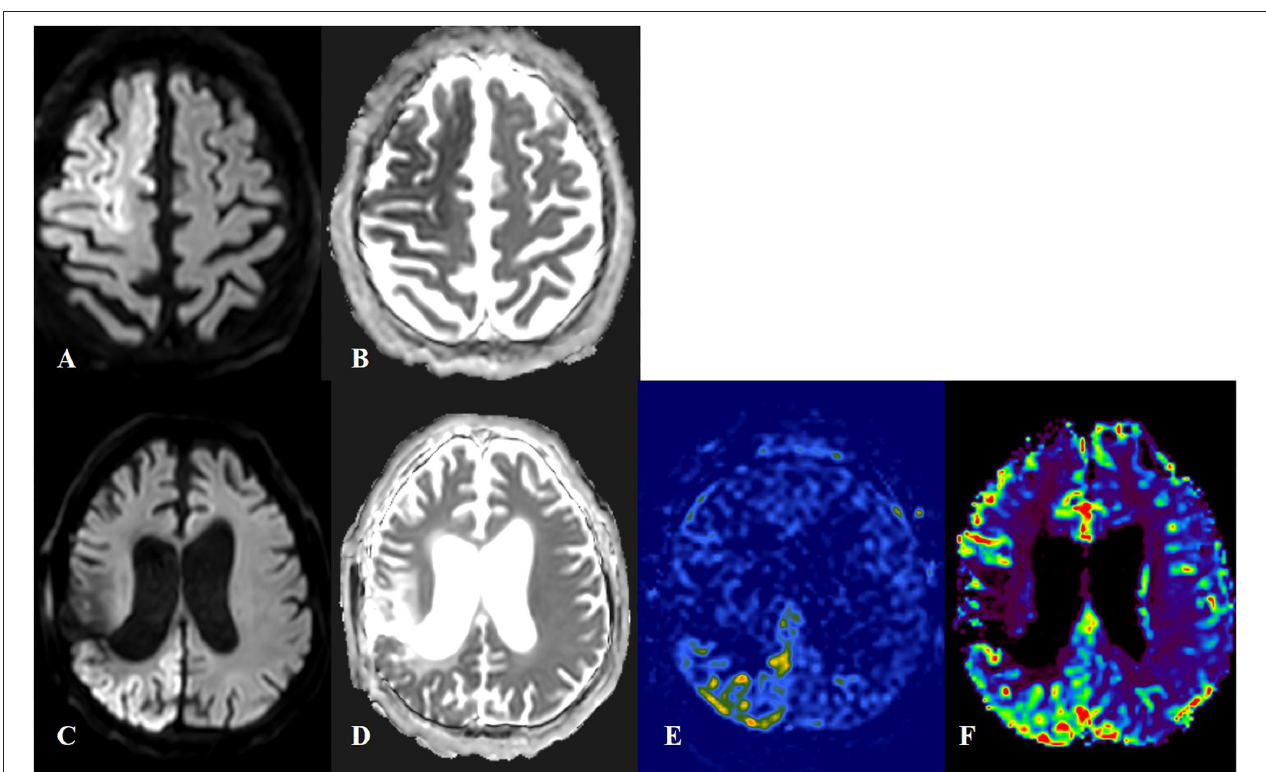
FIGURE 4 | Cortical laminar necrosis in acute ischemic stroke (AIS) and status epilepticus (SE). First row: Patient with AIS in territories of right anterior and middle cerebral arteries, with an increased signal in diffusion-weighted imaging (DWI) (A) and decreased signal in apparent diffusion coefficient (ADC) (B) . Quantification of DWI and ADC signals was done for the lesion side as compared to the contralateral healthy mirror side. The ratio for DWI lesion/healthy side was 1.70 and the ratio for ADC lesion/healthy side was 0.58. Second row: Patient with SE. The DWI-restricted lesion in the right parieto-occipital region (C,D) was suggestive of peri-ictal MRI abnormalities. In arterial spin labeling (E) and MRI-perfusion with a contrast substance (F) , an ictal hyperperfusion in the right parieto-occipital region was observed. The ratio for DWI lesion/healthy side was 1.40 and the ratio for ADC lesion/healthy side was